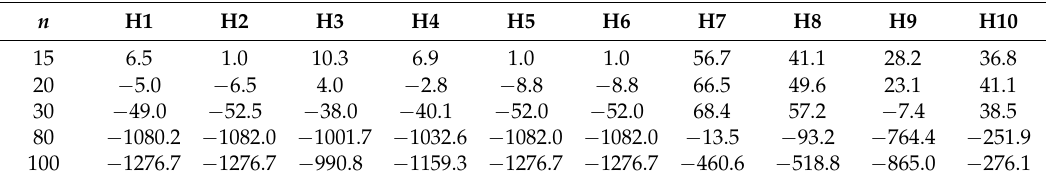
Table 11. Overall performance (average RPD) of heuristics in relation to lower bound given by CPLEX by number of jobs for instances of Group 2.